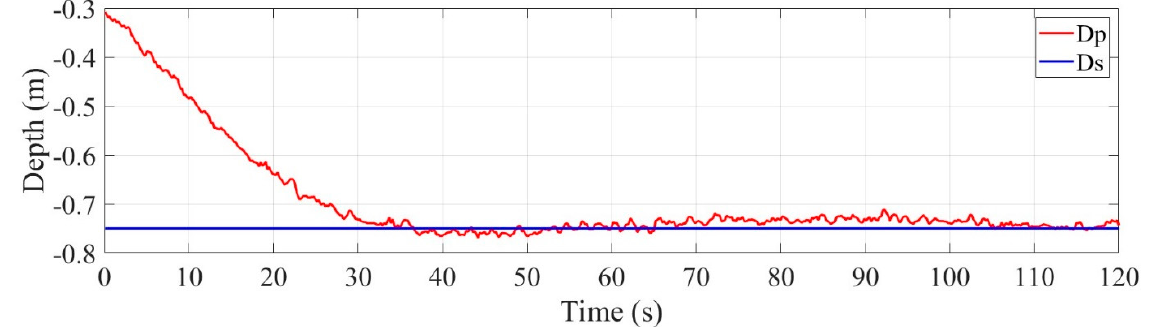
Figure 11. The response depth curve of the station-keeping experiment.